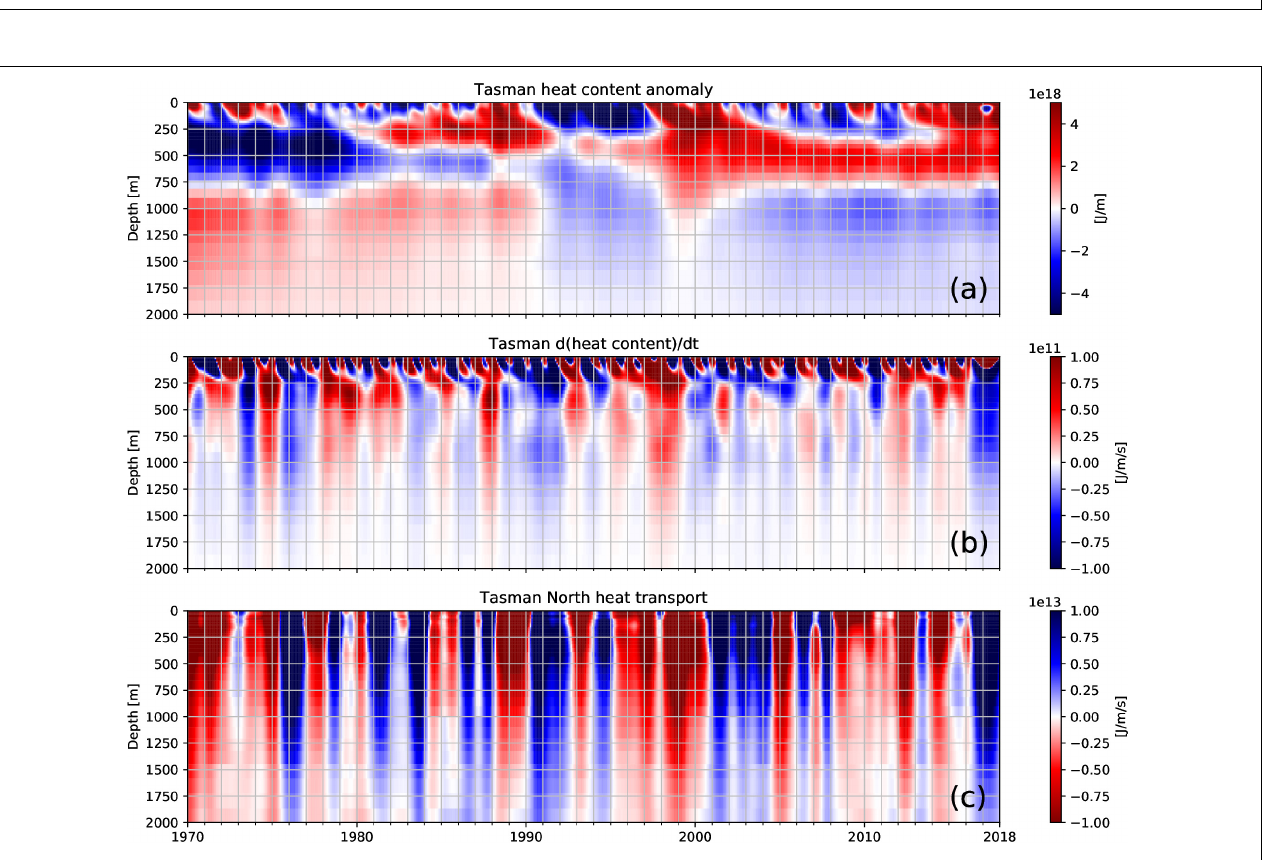
FIGURE 9 | Vertical profiles of (a) Tasman Box heat content anomaly, (b) Tasman Box heat content change and (c) TN heat transport anomalies, interannually filtered. The time averaged profile from 1970 to 2017 has been used as the reference for computing anomalies. Please note the inverted color scale in (c) . All anomalies have been normalized using the vertical model layer